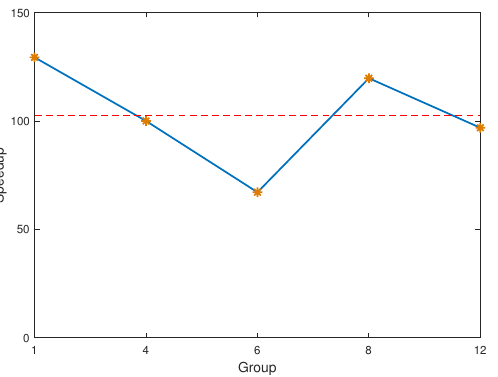
Figure 9. Speedup of the proposed new algorithm over the existing algorithm (horizontal line: average